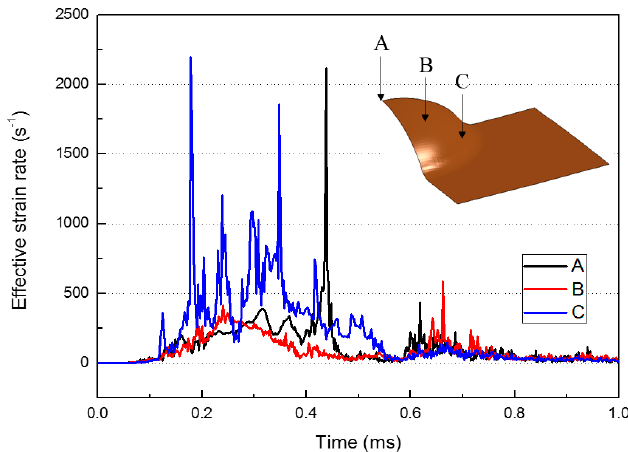
Figure 8. Effective strain rate at different position of deformed blank.